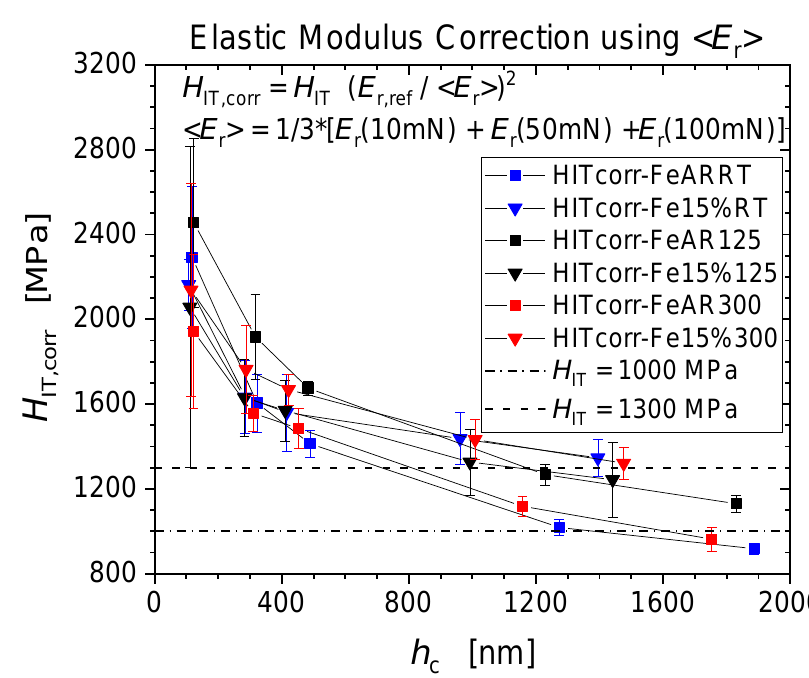
Figure 9. Corrected indentation hardness of un-strained and 15% pre-strained Fe.